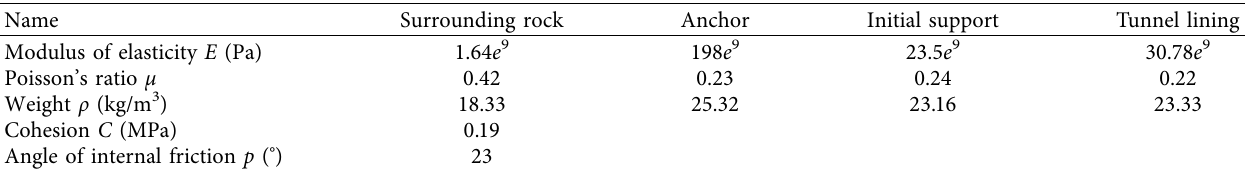
Figure 5: Numerical simulation model: (a) numerical calculation model; (b) tunnel lining; (c) distribution characteristics of joints in surrounding rock; (d) tunnel surrounding rock. Table 1: Rock dynamics